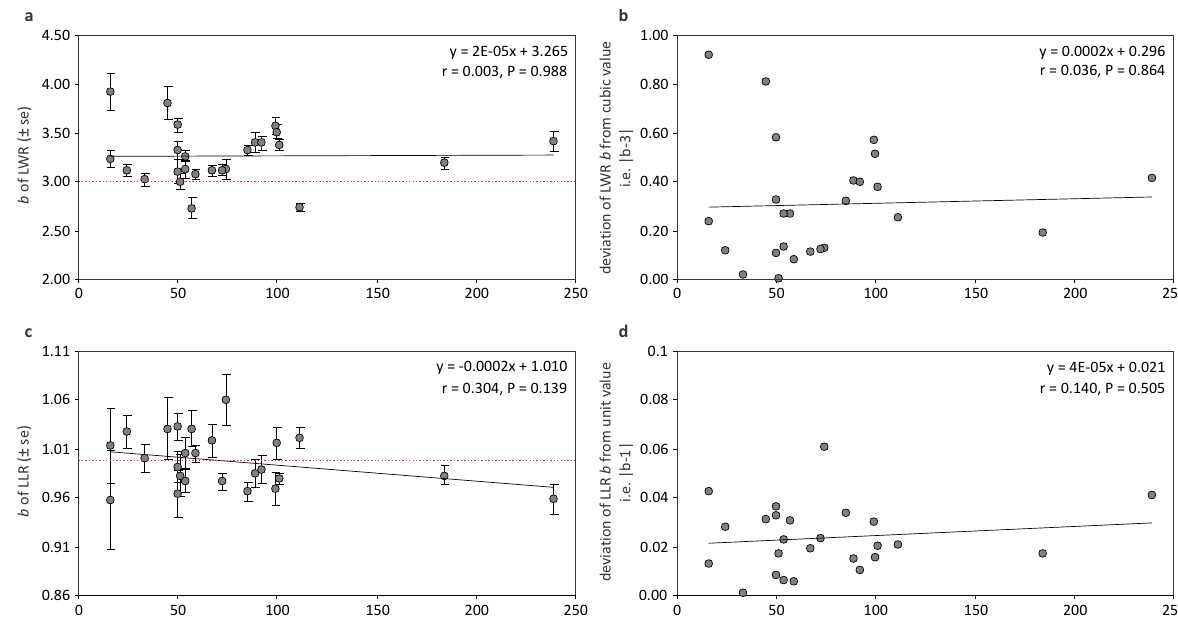
Figure 4. Effect of sample size on (a) b values of the LWR, (b) deviation in the b values of LWR form cubic value expected from isometry, (c) b values of the LLR, (b) deviation in the b values of LLR form unit value expected from isometry. Note that none of the trend lines are significant indicating that the sample size has no effect on the value of b and its deviation from isometry. Red dashed lines in (a) and (c) are expected values from isometric